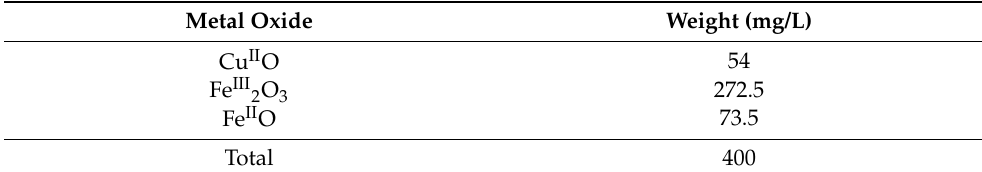
Table 2. Proportion of metal oxides in the Cu II O/Fe III 2 O 3 /Fe II O composite. Metal